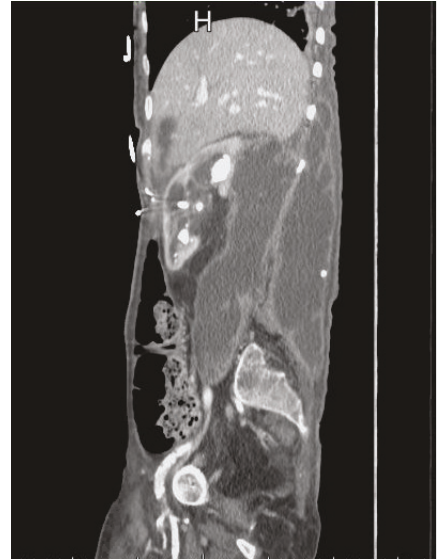
Figure 2: Sagittal section of a CT scan of the abdomen/pelvis with IV contrast revealing severe hydronephrotic right kidney with accompanying urinoma in the